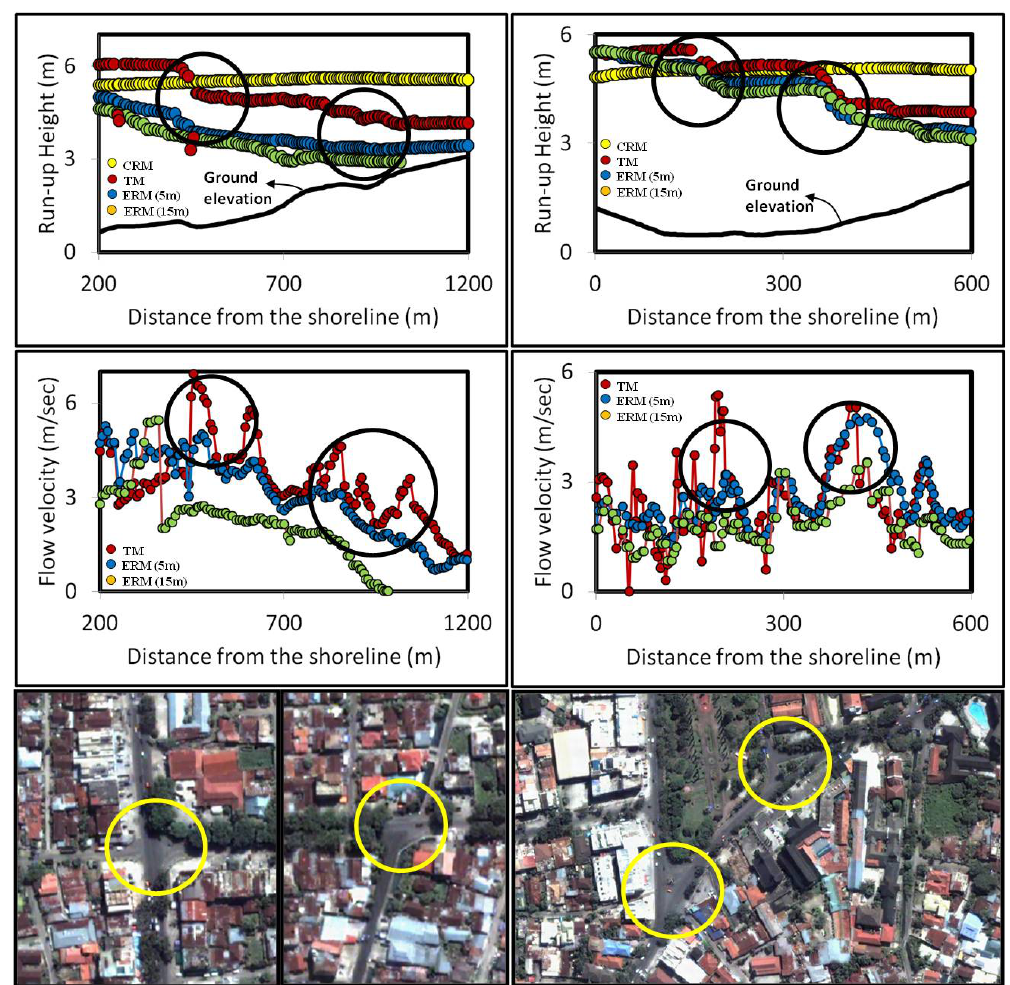
Fig. 15. Run up height and velocity comparison between TM and ERM from the cross-section 1 (left hand side), and the cross section 2 (right hand side). The circles denote the road junctions and corresponding values of inundation height and flow